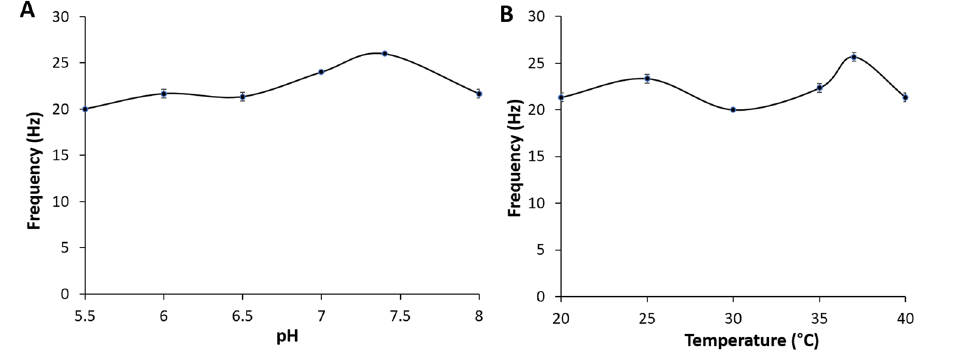
Figure 6. ( A ) Effect of pH on response of the enzymatic glucose biofuel cell at 37 °C in 7 mM glucose; ( B ) Response curve of the enzymatic glucose biofuel cell to 7 mM glucose under various temperatures at 37 °C, pH